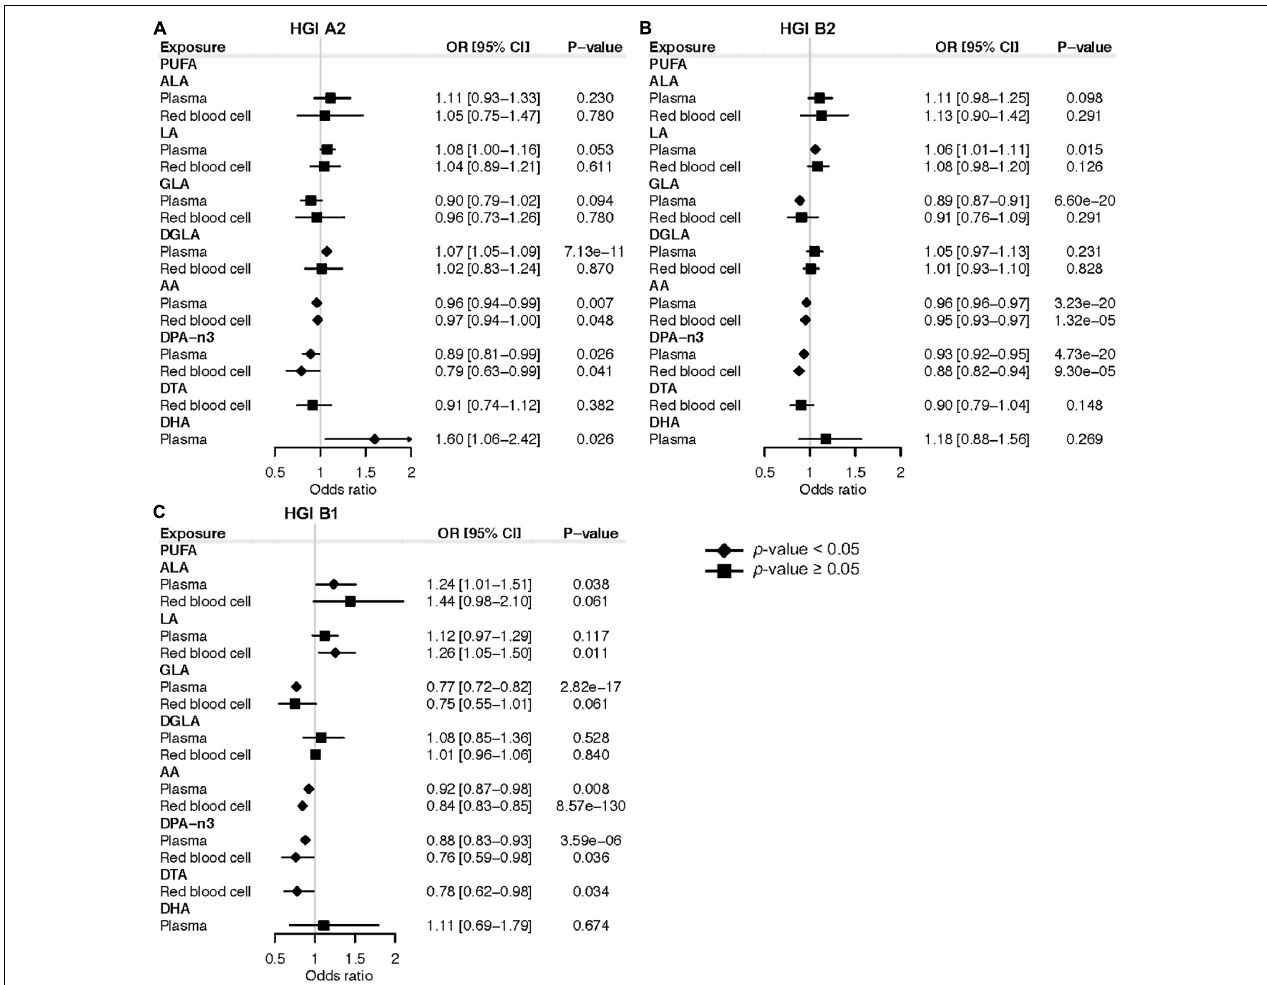
FIGURE 2 | Mendelian randomization estimates of the effects of polyunsaturated fatty acids on COVID-19 severity risk. (A) Mendelian randomization analysis based on the release 5 HGI A2. (B) Mendelian randomization analysis based on the release 5 HGI B2. (C) Mendelian randomization analysis based on the release 5 HGI B1. Odds ratios are scaled to a genetically predicted SD increase in polyunsaturated fatty acids. Associations with p -value < 0.05 were indicated with diamonds, while others with squares. Detailed summary statistics are available in Supplementary Tables 6–8 . PUFA, polyunsaturated fatty acid; ALA, α -linolenic acid; LA, linoleic acid; GLA, γ -linolenic acid; DGLA, dihomo- γ -linolenic acid; AA, arachidonic acid; DPA-n3, docosapentaenoic acid; DTA, docosatetraenoic acid; DHA, docosahexaenoic acid; OR, odds ratio.